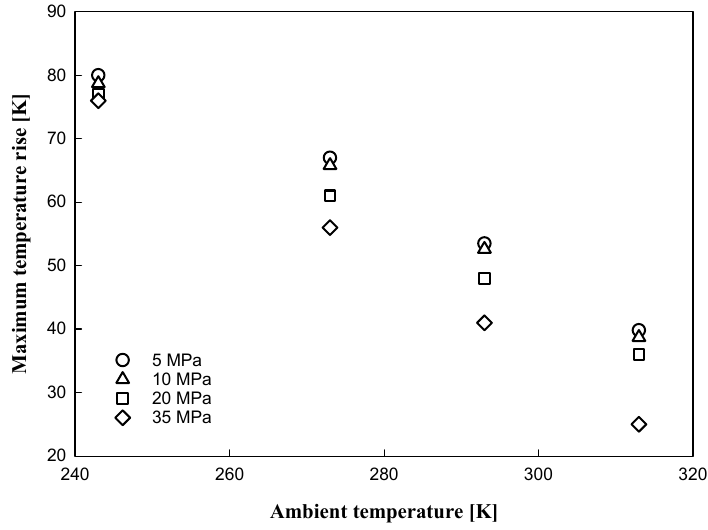
Figure 10. Maximum temperature rise with ambient temperature condition under different SOC pressure conditions.